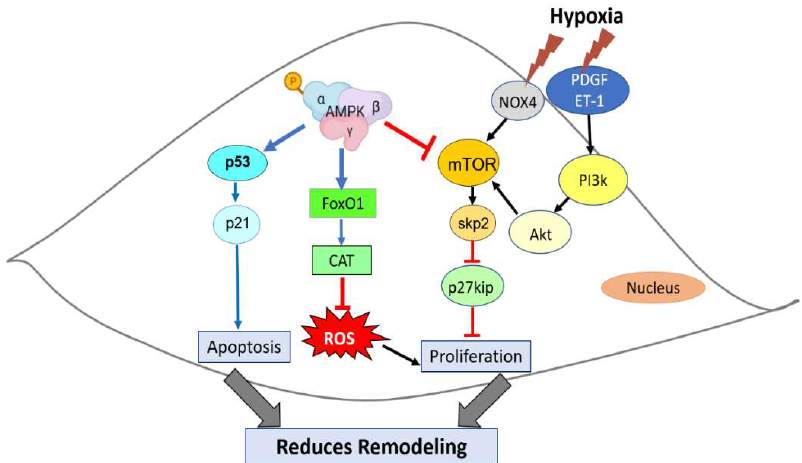
Figure 3. Role of AMPK in reducing PASMC remodeling under hypoxia.